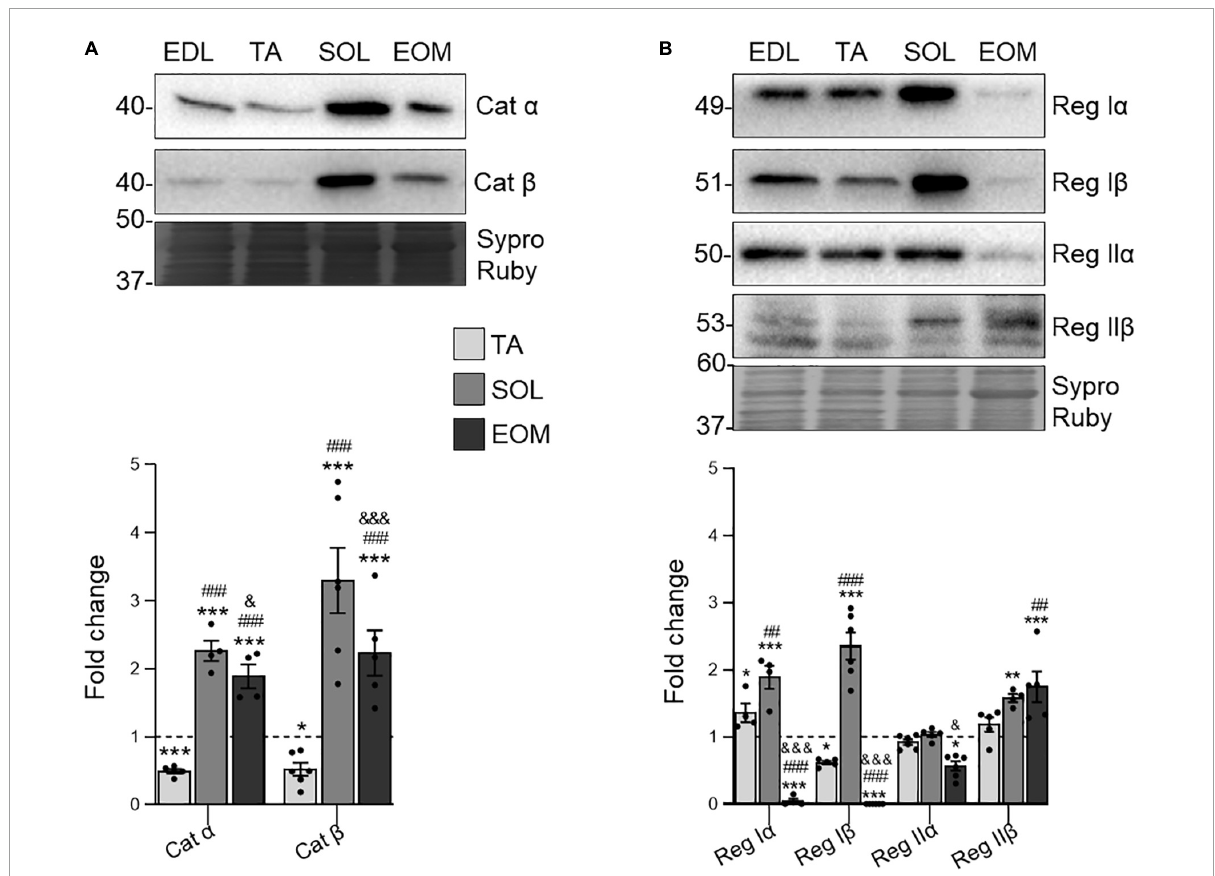
FIGURE4 Catalytic and regulatory PKA subunits expression changes in EDL, TA, SOL, and EOM of Sprague Dawley rats. Western blot analysis and data quantification of (A) catalytic and (B) regulatory PKA isoforms protein levels in different muscles. Sypro Ruby images show the region surrounding each protein of interest despite the bands’ optical densities being normalized using the full length of the lanes. Data are presented as mean ± SEM. Each circle in the bars is the mean result of one animal. * P ≤ 0.05; ** P ≤ 0.01; *** P ≤ 0.001; *against EDL, # against TA, & against SOL (Kruskal–Wallis test and Dunn’s post-hoc test). EDL, Extensor Digitorum Longus; TA, Tibialis Anterior; SOL, Soleus; EOM, Extraocular Muscles. Graphs done with GraphPad Prism software, San Diego,